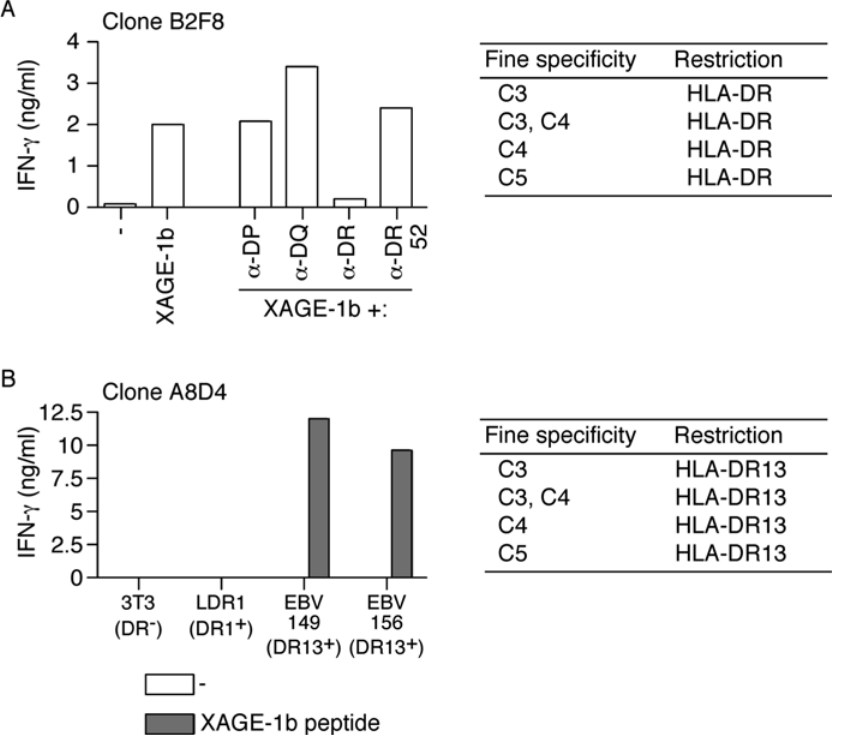
Fig 4. Assessment of the HLA restriction of XAGE-1b-specific CD4 + T-cell clones. (A) Identification of MHC II restricting molecules. The left panel shows an example of an HLA-II restriction assay clone, B2F8. Peptide recognition was assessed by ELISA, incubating XAGE-1b specific CD4 + T-cell clones exhibiting each of the 4 fine specificities either in the absence or in the presence of α DP, α DQ, α DR and α DR52b specific antibodies. Peptide recognition was restricted by HLA-DR in all cases, as summarized in B. The HLA-DR restricting allele was identified by incubating XAGE-1b specific CD4 + T-cell clones with